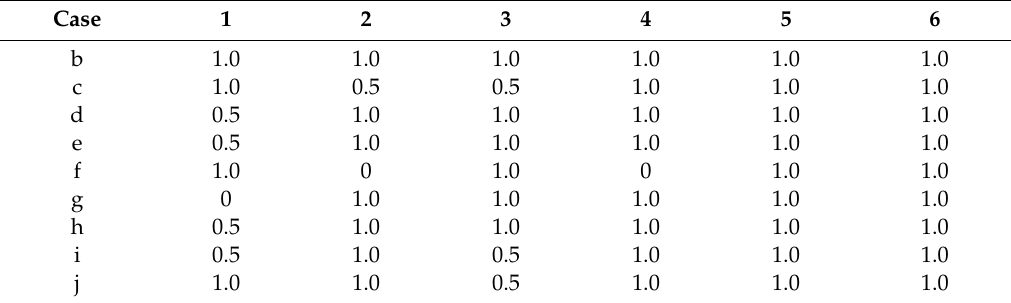
Table 5. Comparison of detection ratio (1.0 = high; medium = 0.5; 0 = low) between the two methods of pile defect diagnosis.